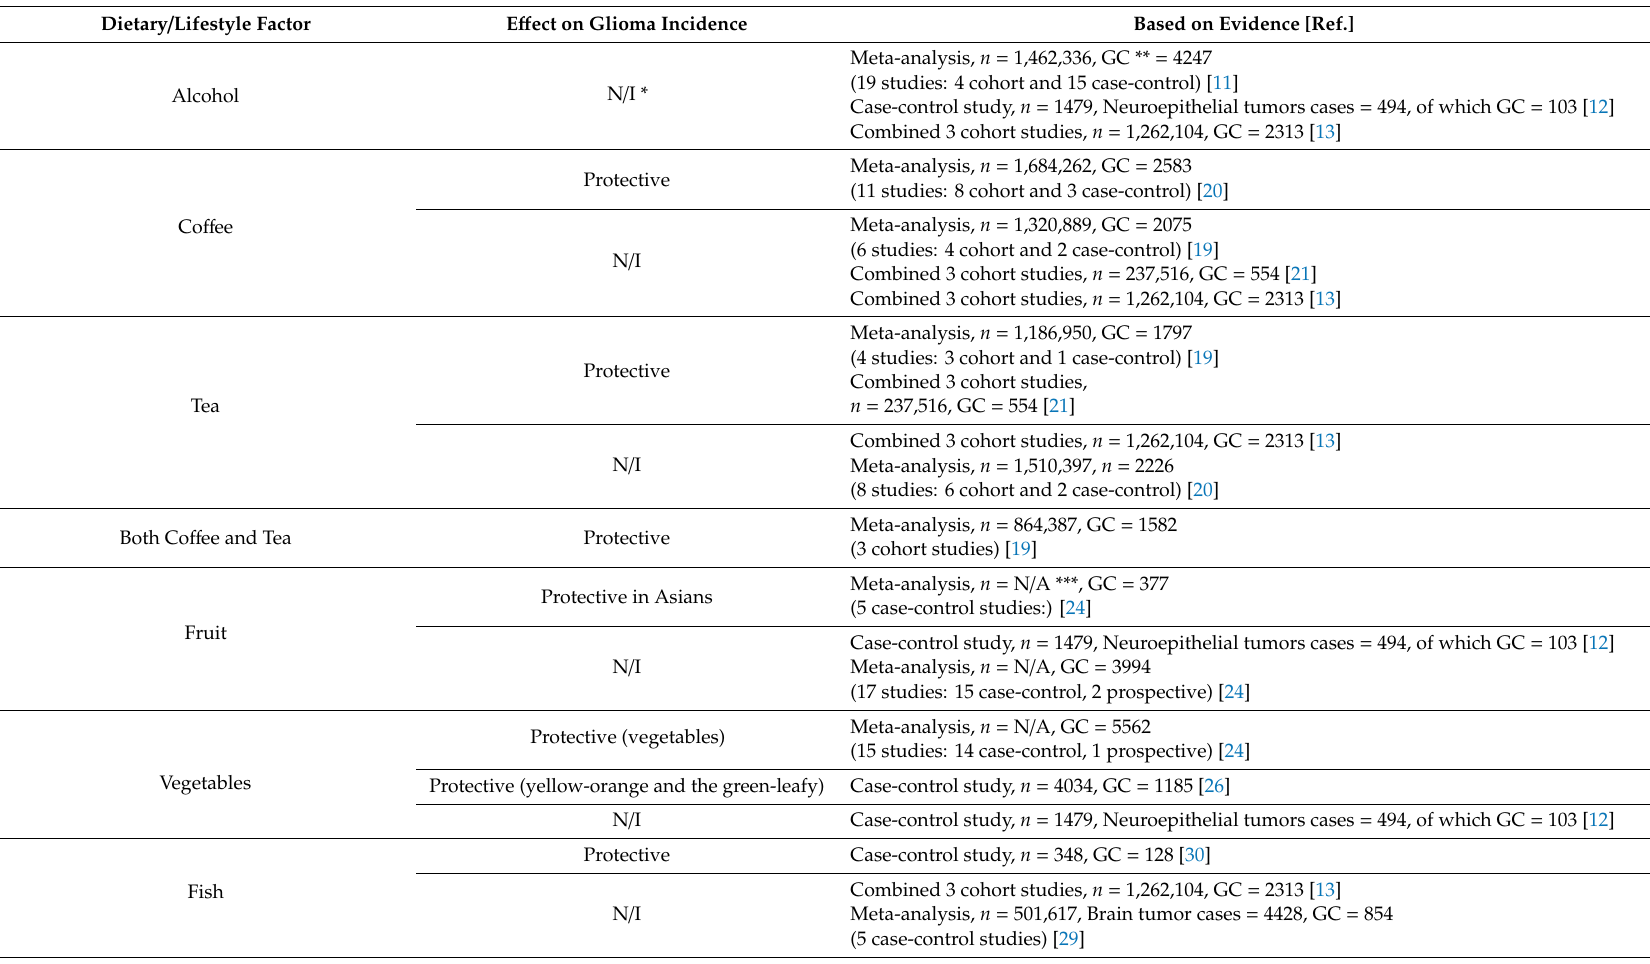
Table 1. The dietary and lifestyle factors discussed in relation to glioma